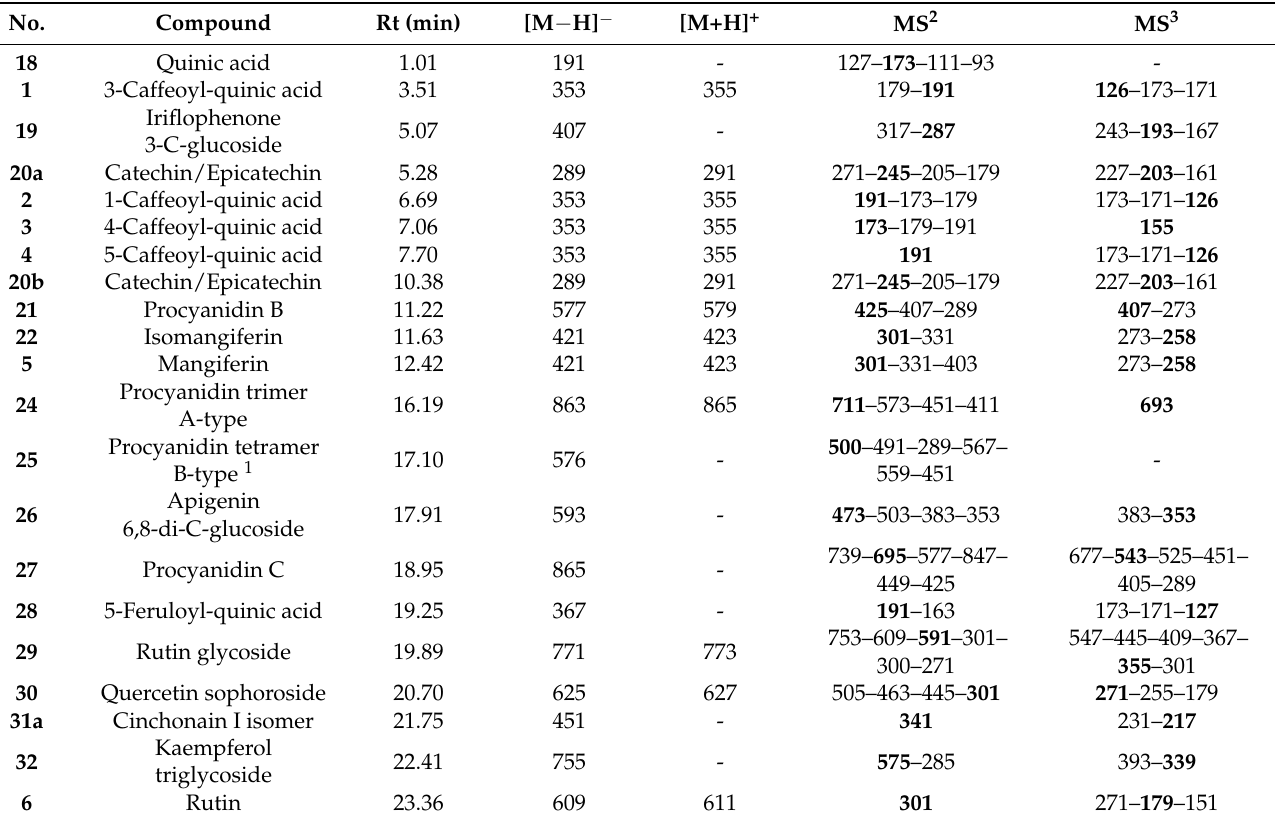
Figure 3. HPLC-ESI( − ) chromatogram of coffee leaves extract. The identified compounds are numbered as also reported Table 3. Table 3. Assignment of identified compounds in HPLC-ESI chromatograms of coffee leaf extracts. The m / z values reported in bold represent the base peak of each spectrum. In MS 2 spectra the base peak was fragmented to generate the MS 3 fragmentation spectra. The MS 2 and MS 3 fragmentations are from HPLC-ESI chromatograms acquired in negative